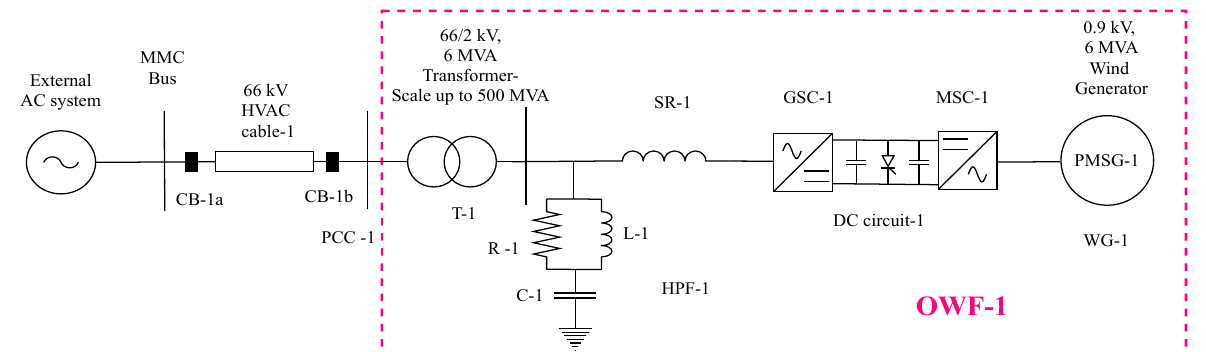
Figure 2. OWF-1 connected to external AC system.